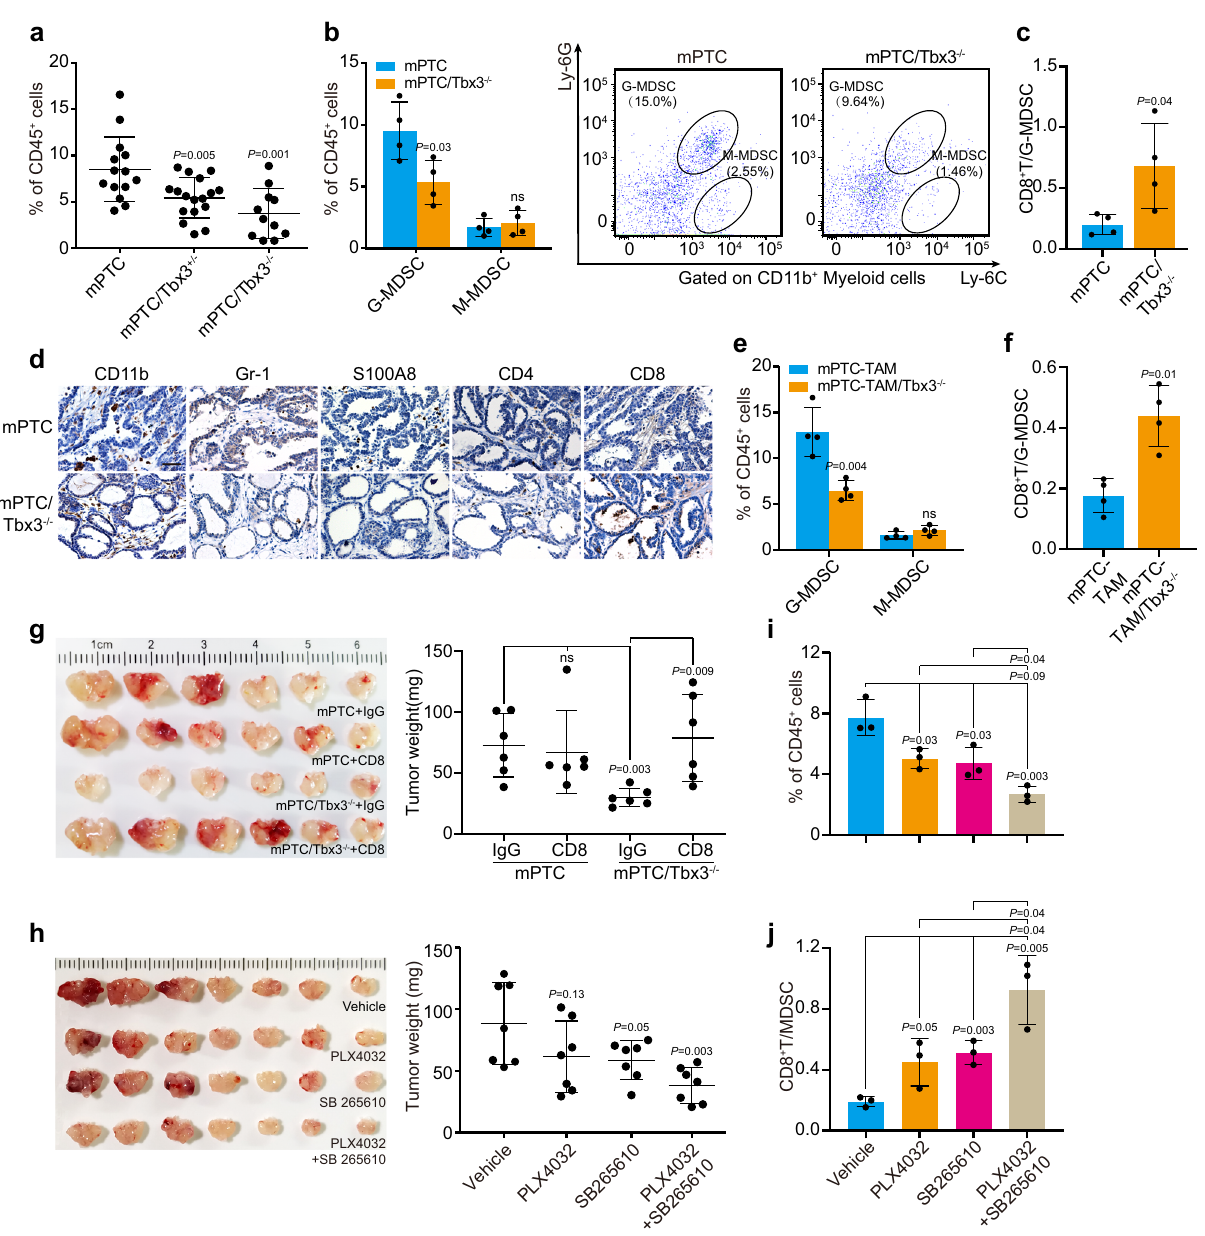
Fig. 6 TBX3 de fi ciency blocked tumor formation due to suppressed CXCR2-mediated MDSCs recruitment. a Flow cytometric analysis of MDSCs (CD45 + CD11b + Gr-1 + ) in thyroid glands from mPTC ( n = 14), mPTC/Tbx3 + / − ( n = 17) or mPTC/Tbx3 − / − ( n = 11) littermates at 5w. b , c Percentage of G-MDSC (CD45 + CD11b + Ly6C - Ly6G + ) and M-MDSC (CD45 + CD11b + Ly6C + Ly6G - ) of CD45 + tumor-in fi ltrating leukocytes (TILs) in mPTC tumors compared with mPTC/Tbx3 − / − littermates at ( b ). Relative CD8 + T cells/MDSCs was plotted ( c ), n = 4. d IHC analysis of CD11b, MDSCs (Gr-1, S100A8), CD4 + T cells (CD4) and CD8 + T cells (CD8) in thyroid glands from mPTC/Tbx3 − / − compared with mPTC littermates. Scale bars, 50 μ m. e , f Flow cytometric analysis of G-MDSC and M-MDSC in mPTC-TAM or mPTC-TAM/Tbx3 − / − tumors induced with tamoxifen for 8m. CD8 + T cells/MDSCs was plotted, n = 4. g Mice bearing mPTC and mPTC/Tbx3 − / − tumors were treated with 200 μ g anti-CD8 antibody per mouse twice weekly at age of 3w for 20d. Tumor weights were counted, n = 6. h Mice bearing tumors received daily oral doses of PLX4032 10mg/kg body weight or SB265610 2mg/kg body weight at age of 3w for 20d. Tumor weights were counted, n = 7. i , j Flow cytometric analysis of mPTC tumors underwent above treatments. Percentage of positive cells relative to total cells was plotted. MDSCs ( i ) and CD8 + T cells/MDSCs ( j ), n = 3. A representative of three independent experiments was shown ( d ). Data are shown as the mean ± s.d. ( a – c , e – j ). P values were calculated by unpaired two-tailed Student ’ s t test ( a – c , e – j ). Statistical source data are provided in Source Data. transcription. In comparison, c-Jun speci fi cally binds with -371 (here termed as -360) AP-1 site and transactivates TBX3 expression during breast cancer development 48 . The preference for different AP-1 sites may relate very much to the epigenetic modi fi cation and chromatin state under each tumor initiation.